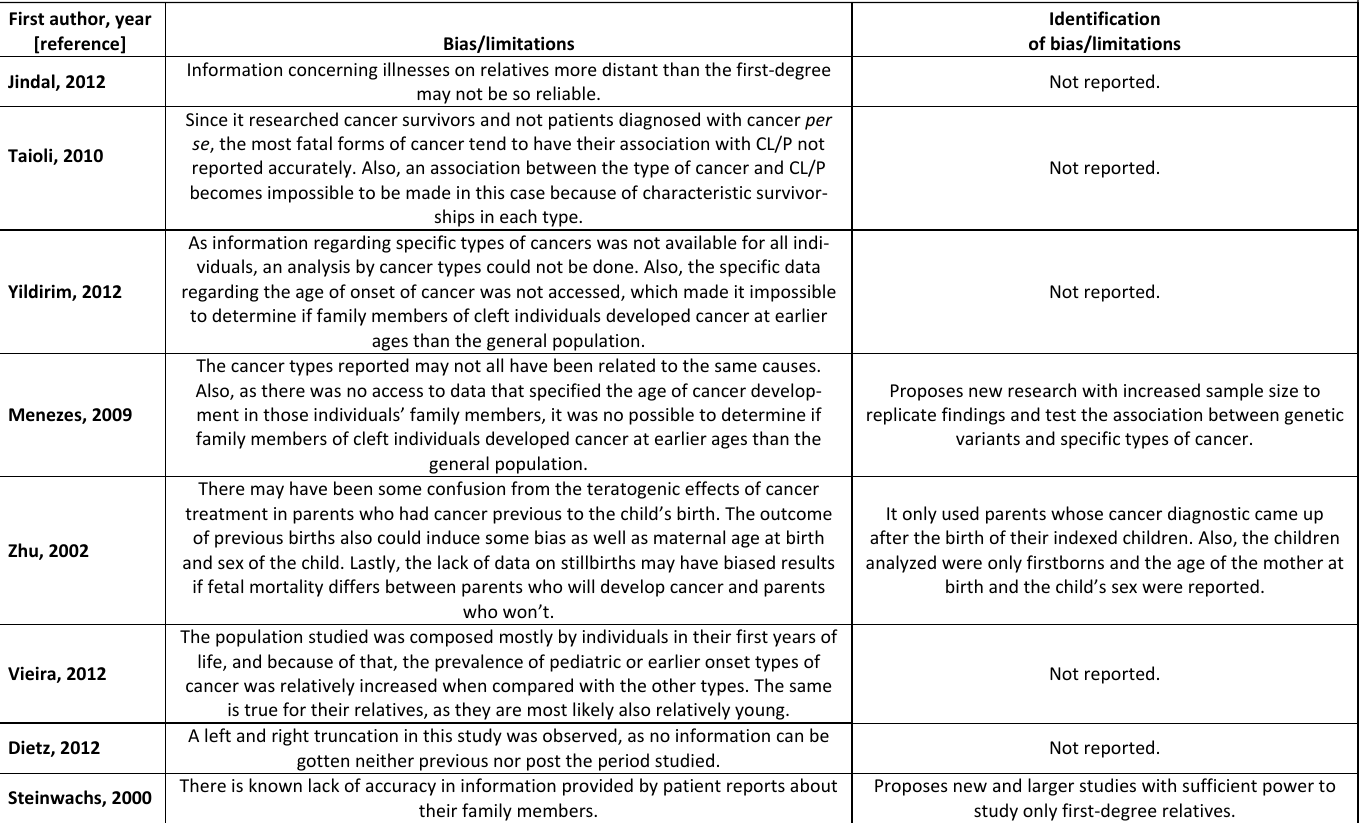
Table 4: Poten (cid:415) al bias/limita (cid:415) ons and the author’s e ff orts to iden (cid:415) fy them among the eight selected papers.